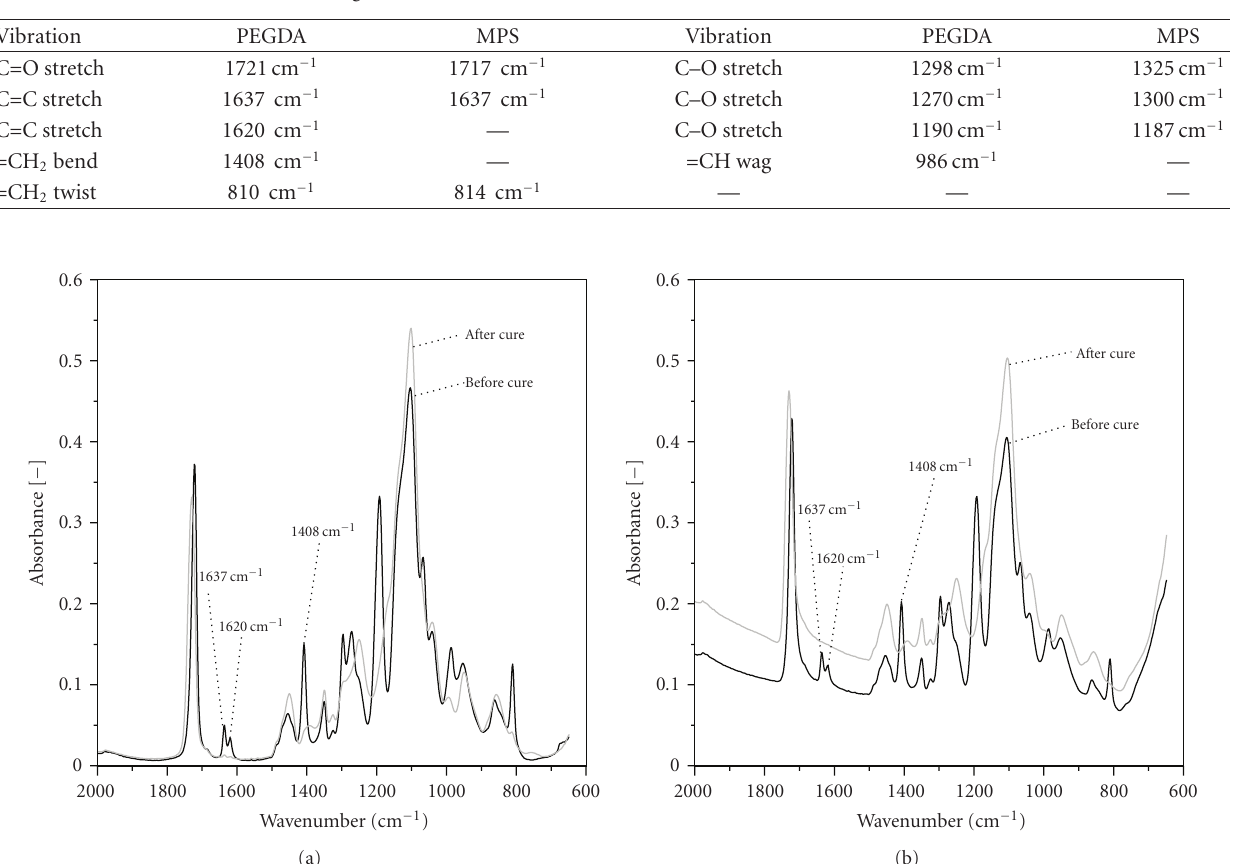
Table 3: Assignment of the characteristic FT-IR bands of PEGDA 575 and MPS [29].